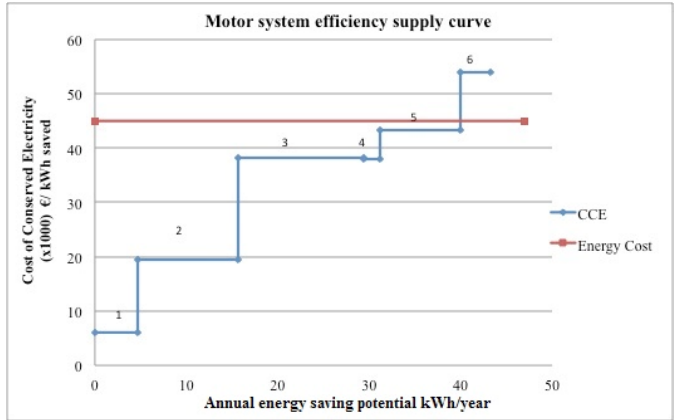
Figure 12. The CSC for the measures proposed for the case under study. Table 6. Cumulative annual electricity saving by proposed